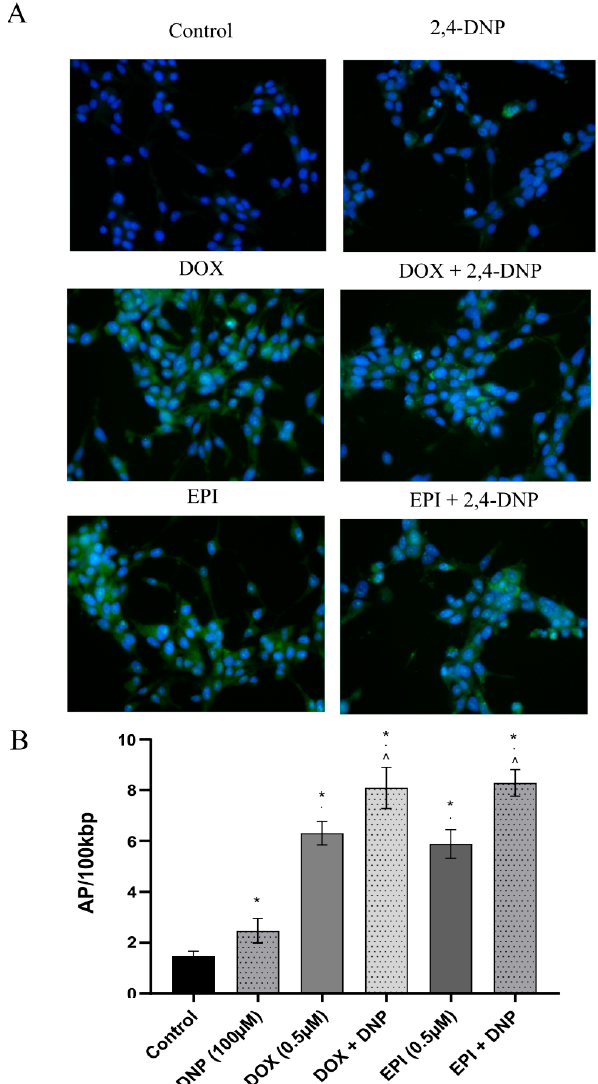
Figure 7. ( A ) The presence of oxidative stress in LNCaP cells. The cells were treated for 24 h with 2,4-DNP, DOX and EPI or combined (2,4-DNP + EPI, 2,4-DNP + DOX). ( B ) AP sites’ level in DNA of LNCaP cells. The cells were treated for 48 h with 2,4-DNP, DOX and EPI or combined (2,4-DNP + EPI, 2,4-DNP + DOX). The values obtained from three independent experiments were presented as mean ± SD. * p < 0.05 vs. control, · p < 0.05 vs. 2,4-DNP, ^ p < 0.05 vs. DOX, EPI.